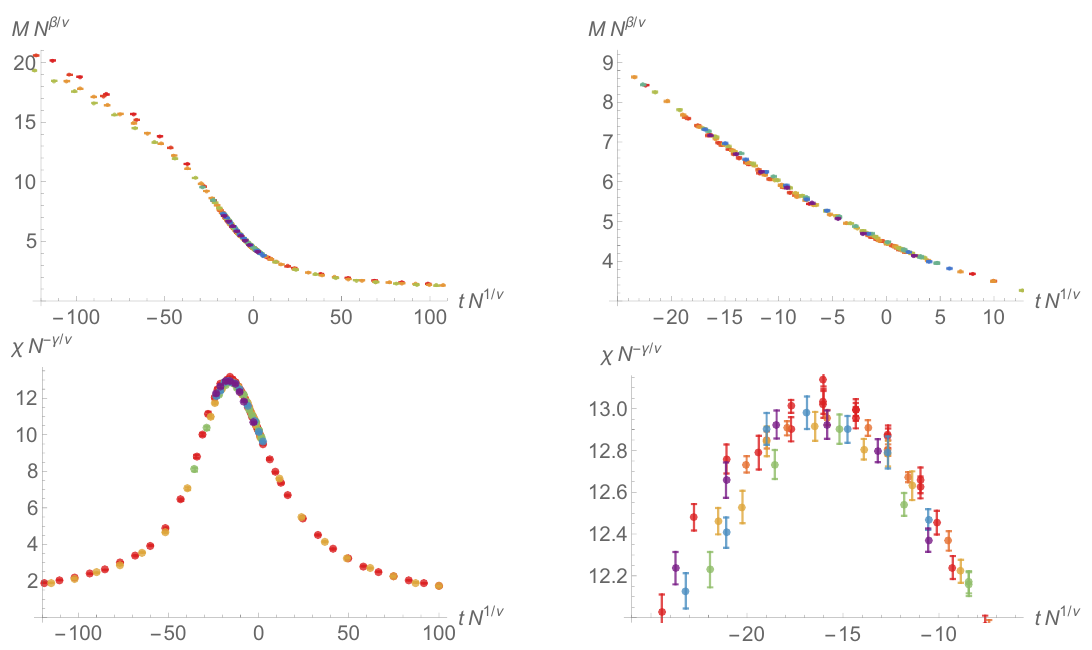
Figure 9 . Collapsed diagrams for l→↑↑ transition at 1 . 00(2) , β = 0 . 40(2) and γ = 0 . 05(1) . Different colors represent different matrix sizes up to N = 50